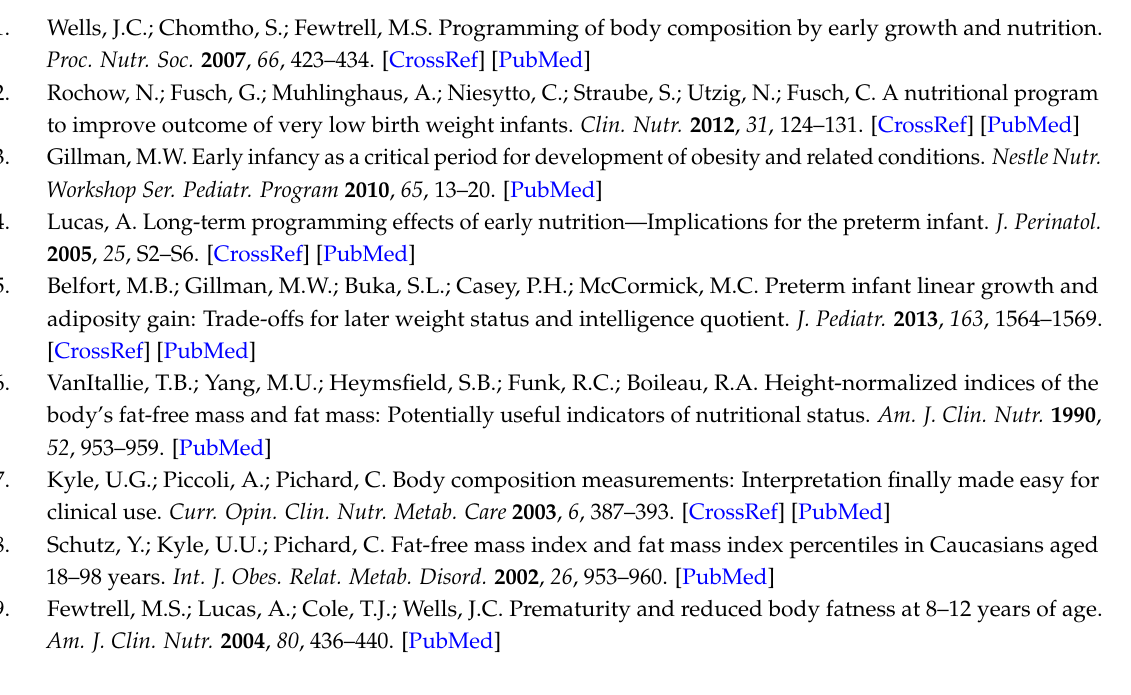
Table S1: Length normalized indices in preterm infants, Table S2: Length normalized indices in term